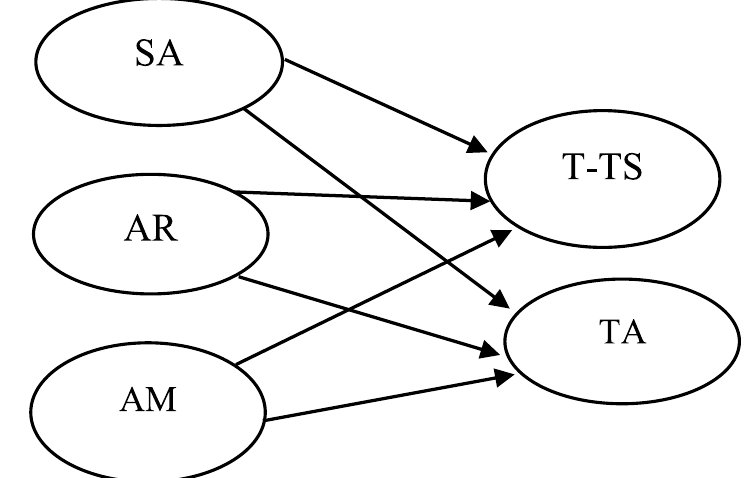
Fig. 1 Theoretical structural equation